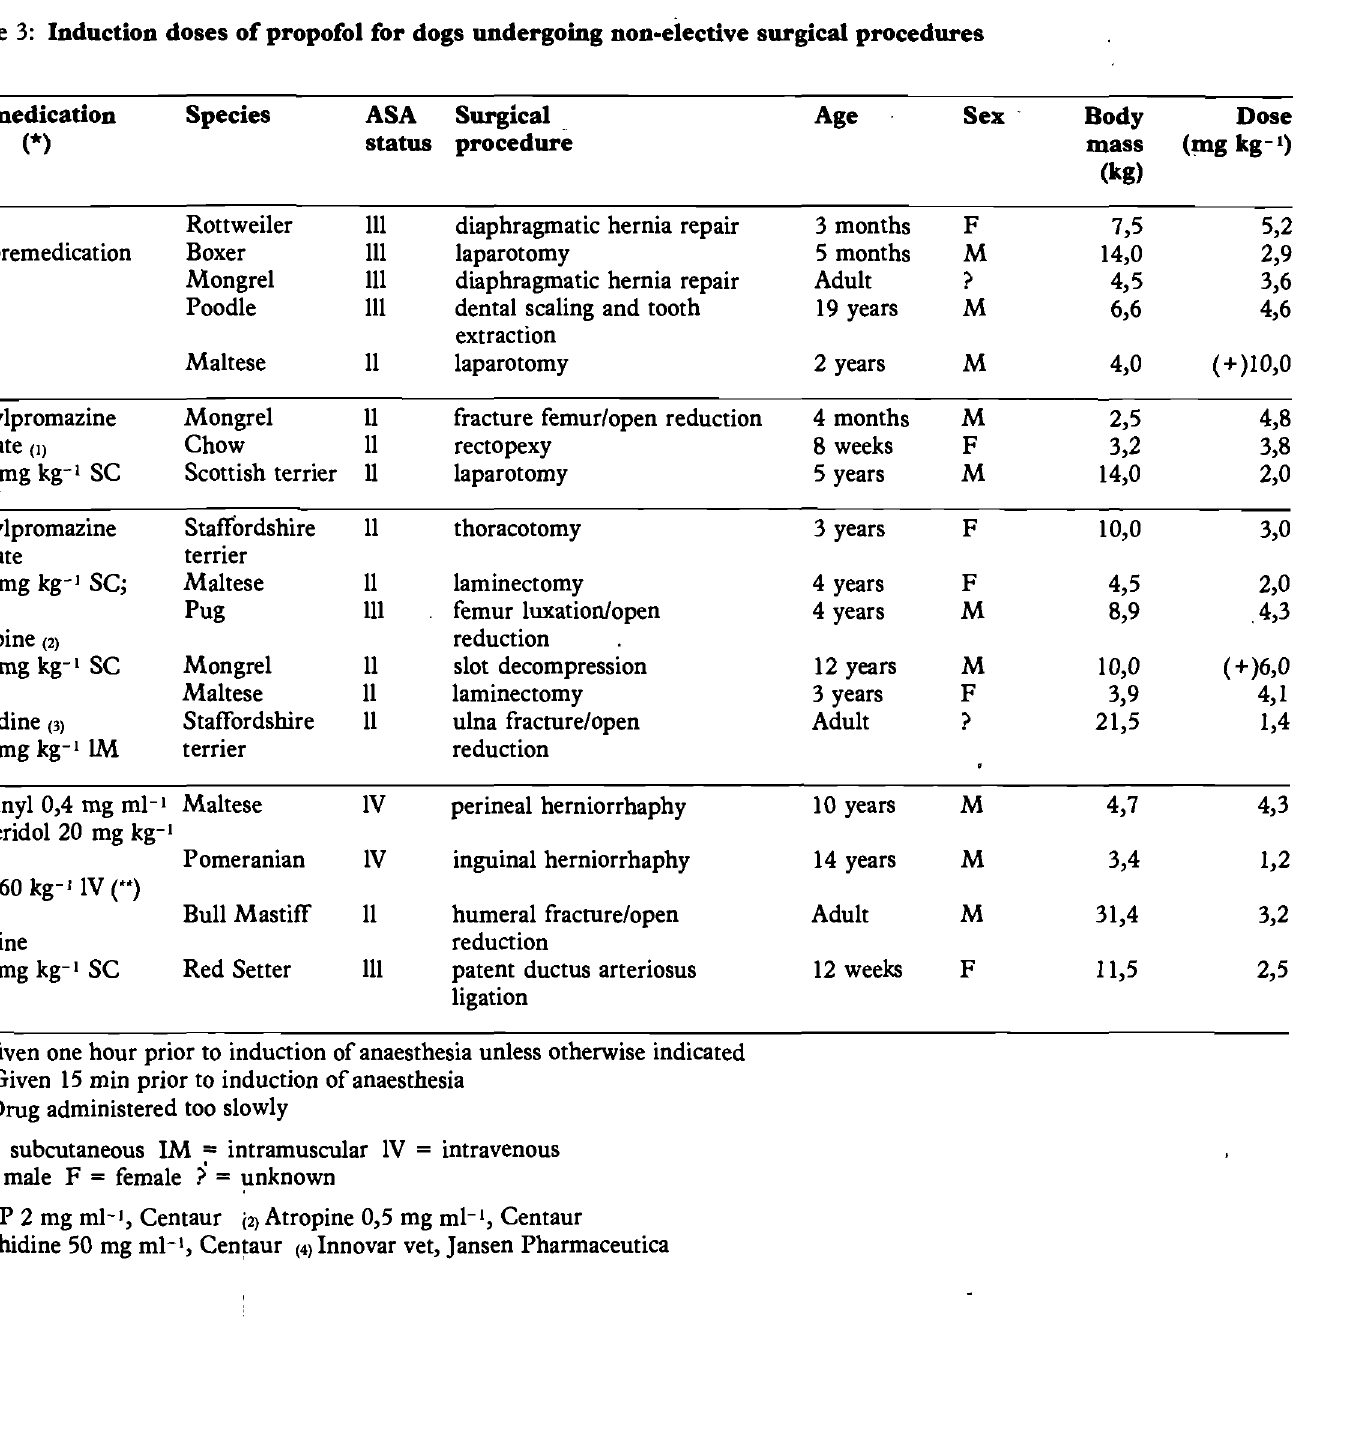
Table 3: Induction doses of propofol for dogs undergoing non-eiective surgical procedures